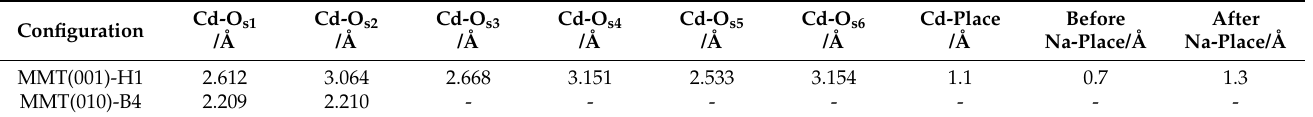
Figure 4. Stable adsorption configurations: ( A ) MMT(001)-H1 and ( B ) MMT(010)-B4 Table 2. Adsorption configuration parameters. Table 2. Adsorption configuration